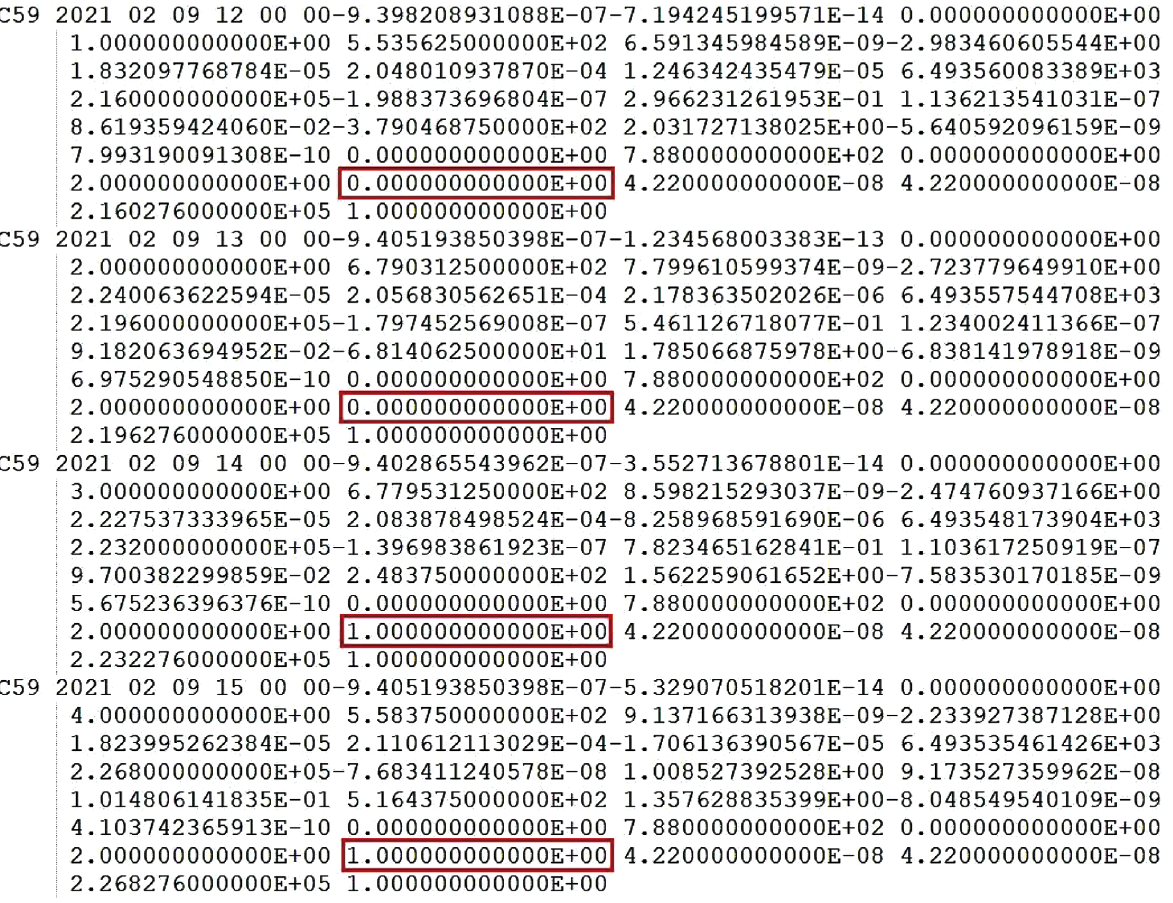
Figure 1: Health marker for C59 in broadcast ephemeris on February 9,